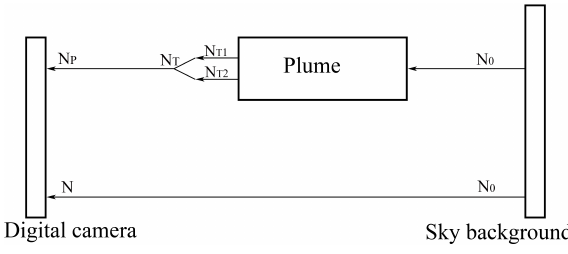
Figure 2. Schematic of the transmission model determining plume